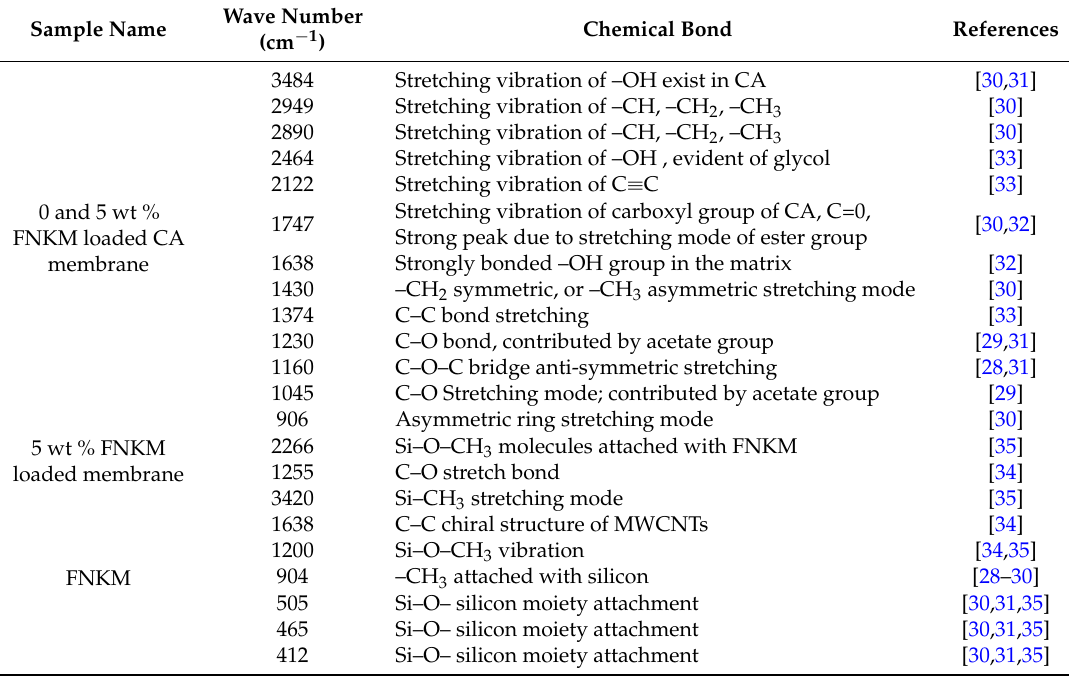
Table 1. Containing major functional groups and their transmittance frequency